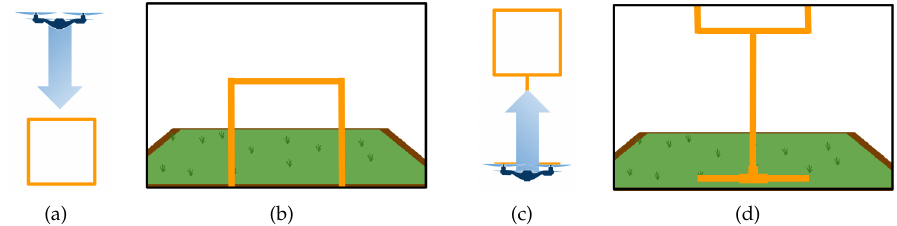
Figure 8. Schematic drone’s vertical motion: ( a ) outside view of the drone’s motion flying upwards when the gate appears at the bottom of the image ( b ); ( c ) downwards motion when the gate appears at the top of the image ( d ). The flight command h will take values in the range of [ − 1,1 ] ; values for ( φ , θ , ψ ) will be set to